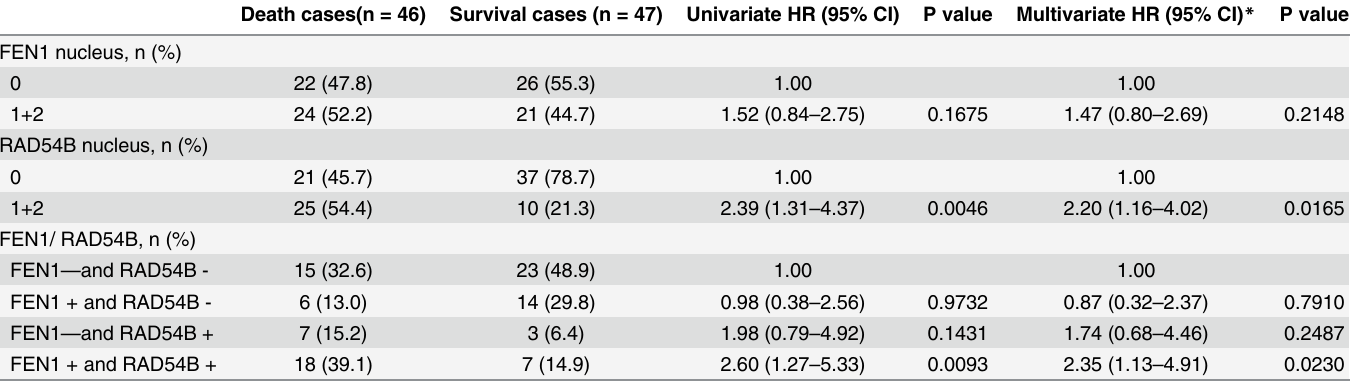
Table 4. Univariate and multivariate analysis of FEN1 and RAD54B in lung adenocarcinoma